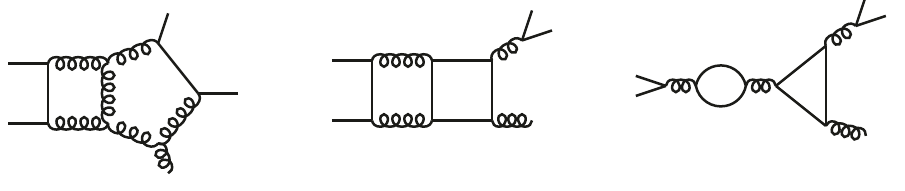
Figure 5 . Representative Feynman diagrams for leading-color A (2) ( q; (cid:22) q; Q; (cid:22) Q; g ) amplitudes, con- tributing at order N 0